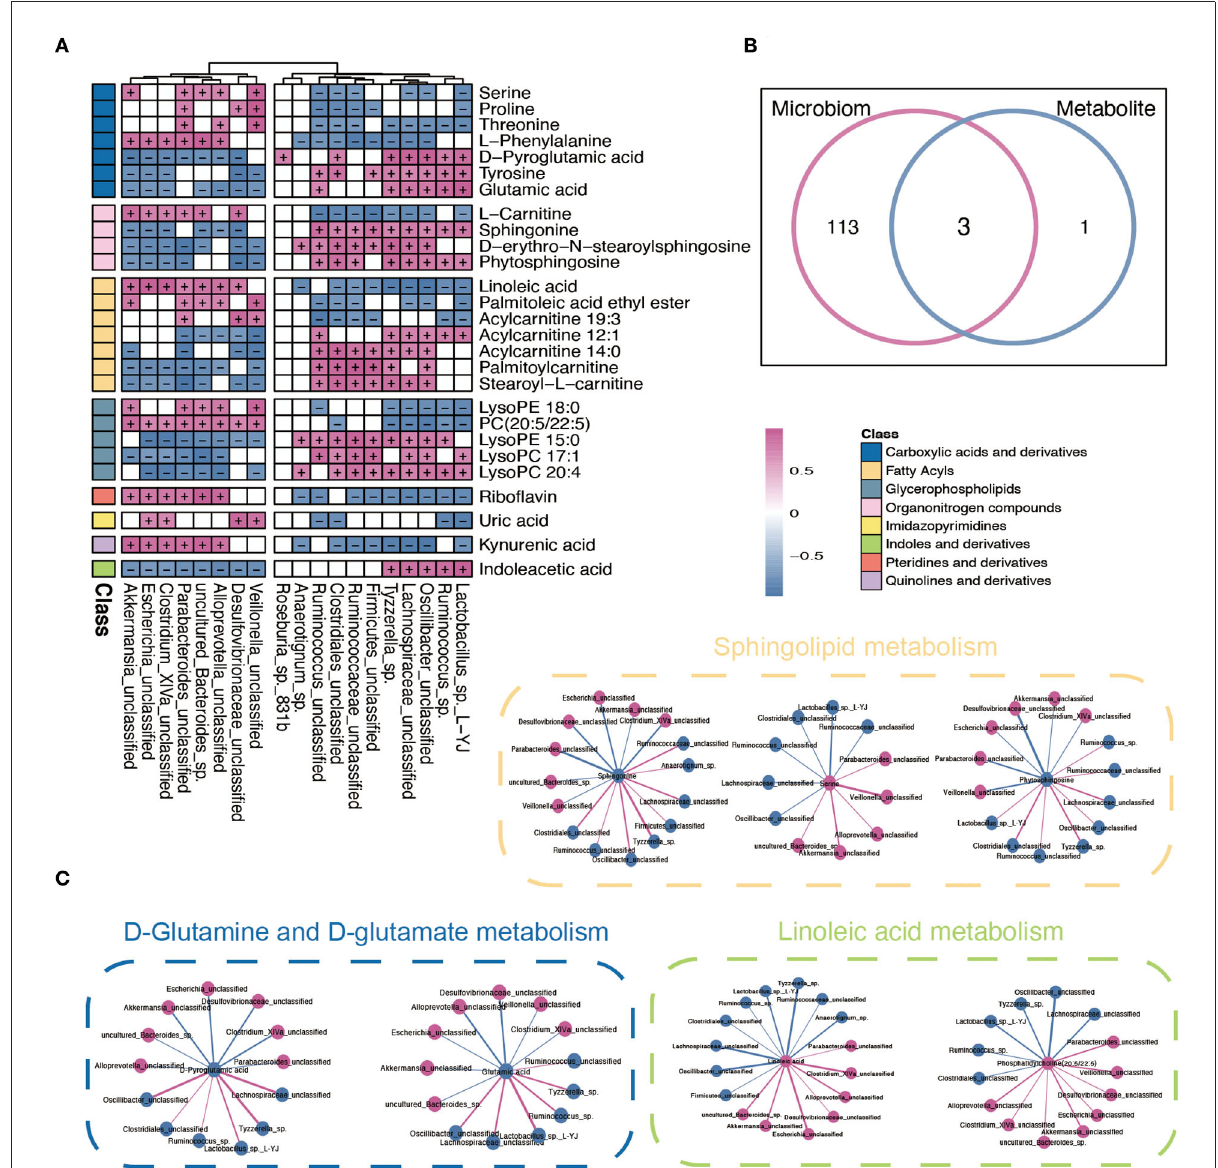
FIGURE5 Integrated analysis between microbiome and metabolites. (A) The Spearman correlation analysis between significantly changed microbiome and metabolites. + and – indicate the significantly positive and negative association, respectively. (B) A Venn diagram of significant differential KEGG pathways in functional analysis of gut microbiota and the metabolic pathway based on the metabolites. (C) Interaction network plots of enriched metabolites in the shared pathways with microbes that participate in their metabolism. Red colors indicate significantly upregulated metabolites or microbes, while blue colors indicate significantly downregulated metabolites or microbes. Red and blue lines indicate the positive and negative correlation, respectively.